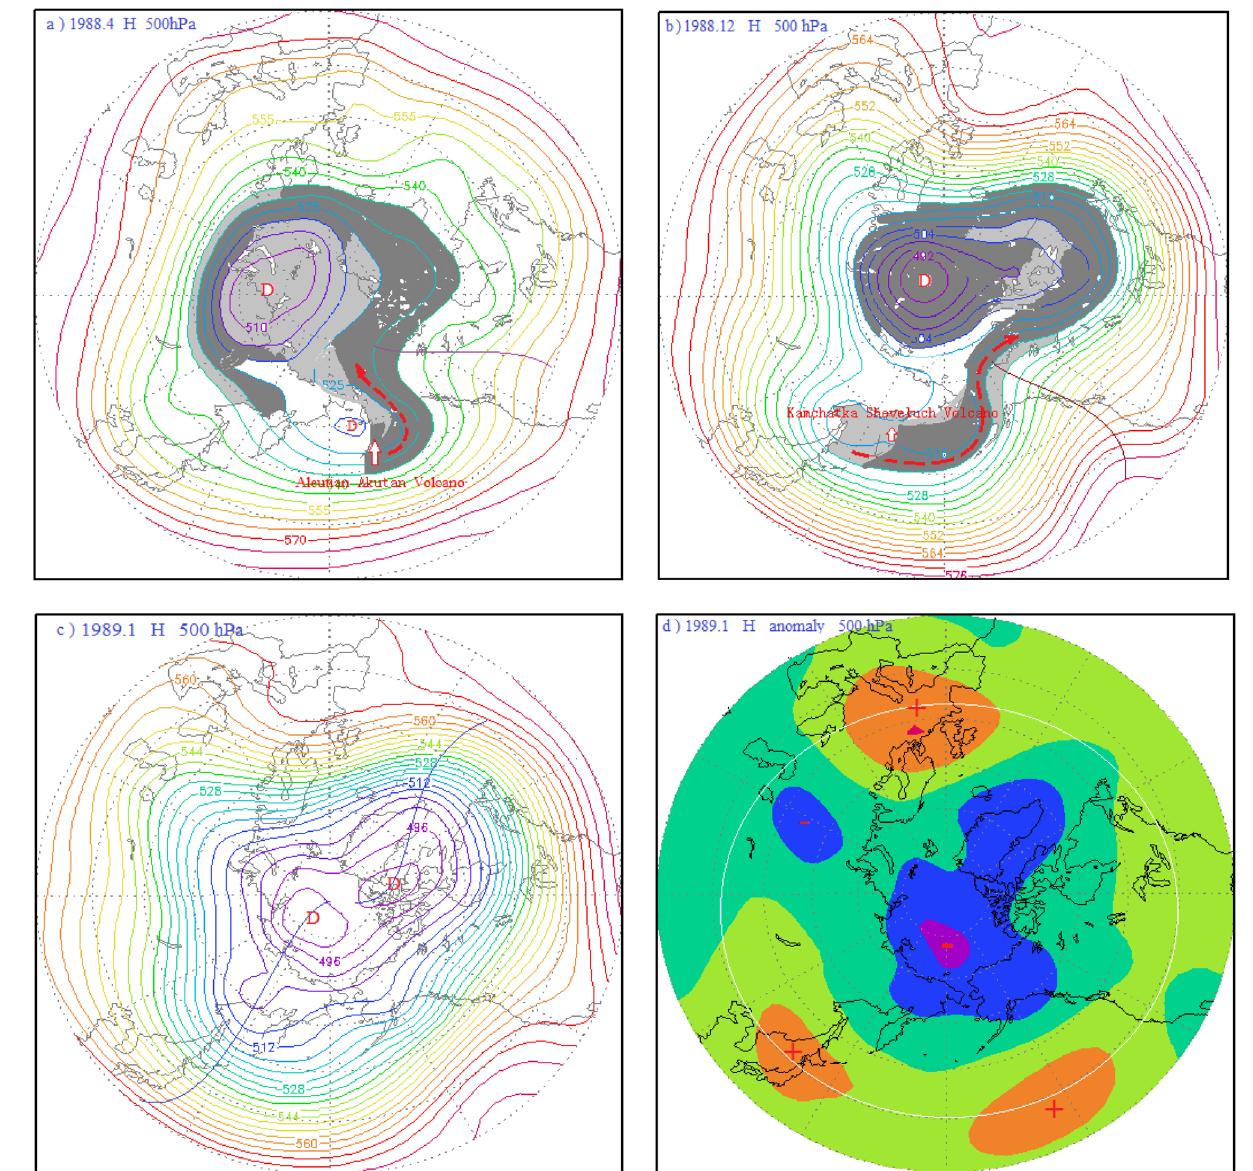
Figure 3. ( a ) 500 hPa atmospheric circulation characteristics and distribution diagram of the volcanic dust curtain and aerosol layer in the mid-high latitudes of the Northern Hemisphere in April 1988; ( b ) schematic diagram of the atmospheric circulation characteristics of the 500 hPa layer from 40 to 90° N and distribution of the volcanic dust curtain and aerosol layer in December 1988; ( c ) atmospheric circulation characteristics of the 500 hPa layer from 30 to 90° N in January 1989; ( d ) potential height field anomaly distribution of the 500 hPa layer from 30 to 90° N in January